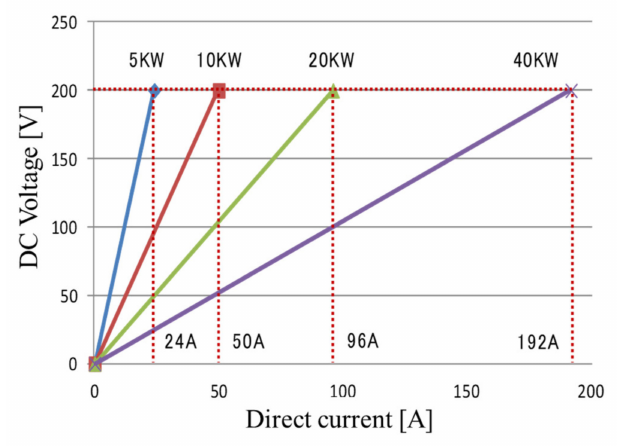
Figure 5. Output of high-frequency induction heating